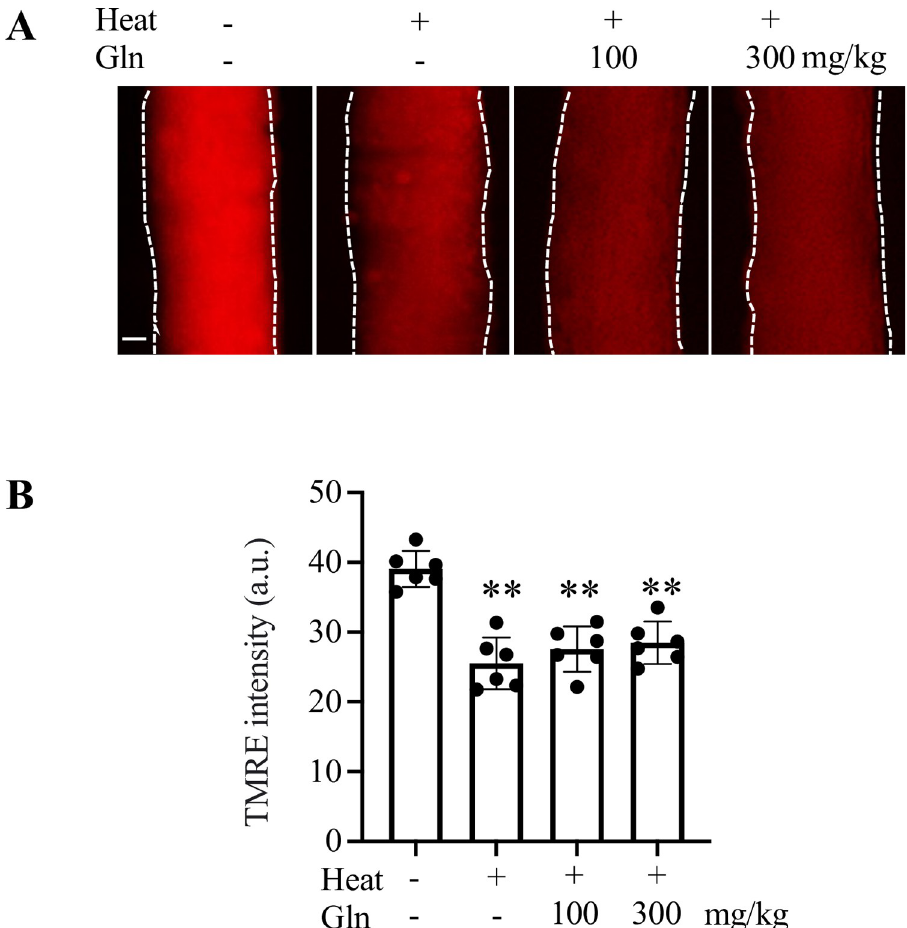
Fig 4. Mitochondrial membrane potential in flexor digitorum brevis muscle of sham and heat-exposed mice. A: Representative images show TMRE-stained myofibers from each group (scale bar: 10 μ m). B: Fluorescence intensities were quantified on randomly selected 20 myofibers per animal and expressed in arbitrary units (a.u.). Values are mean ± SD. �� p < 0.0001, n = 6 mice per group.